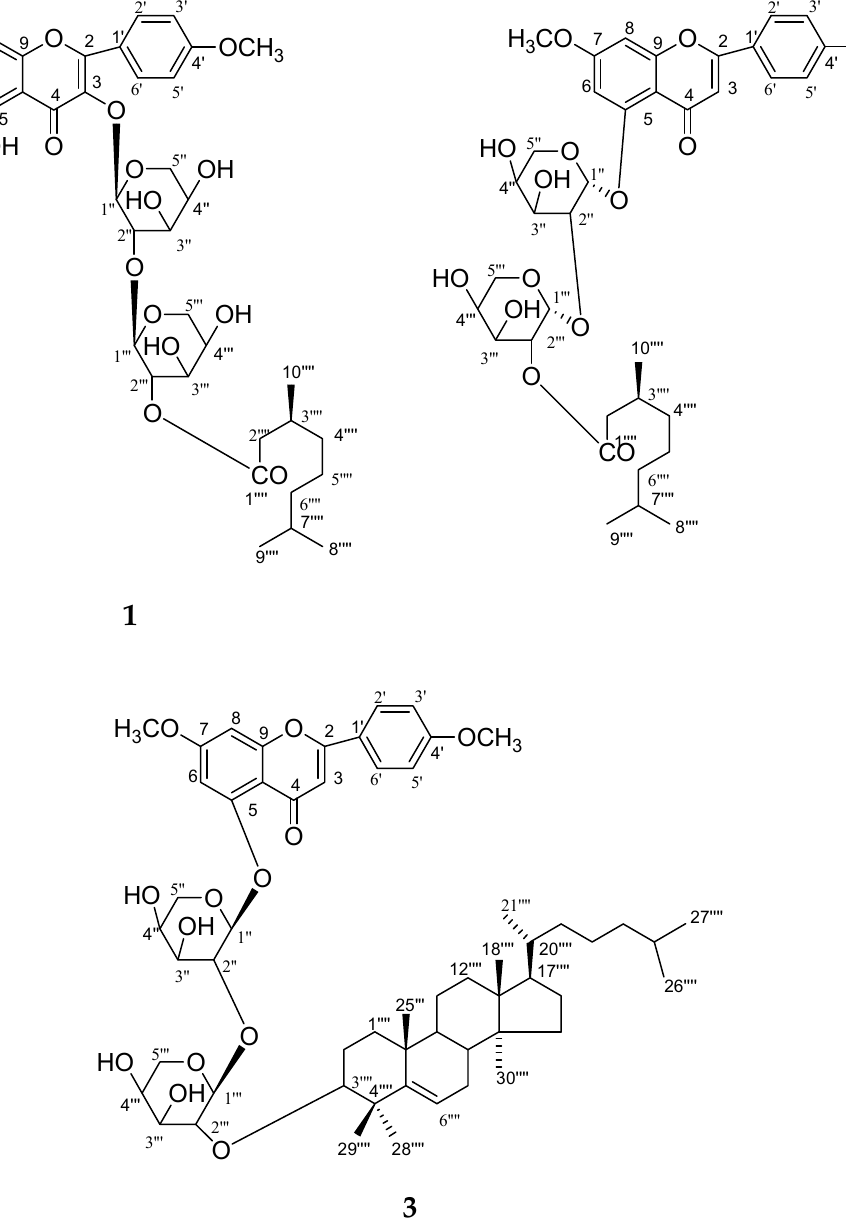
Figure 1. Chemical structure of compounds 1 – 3 .